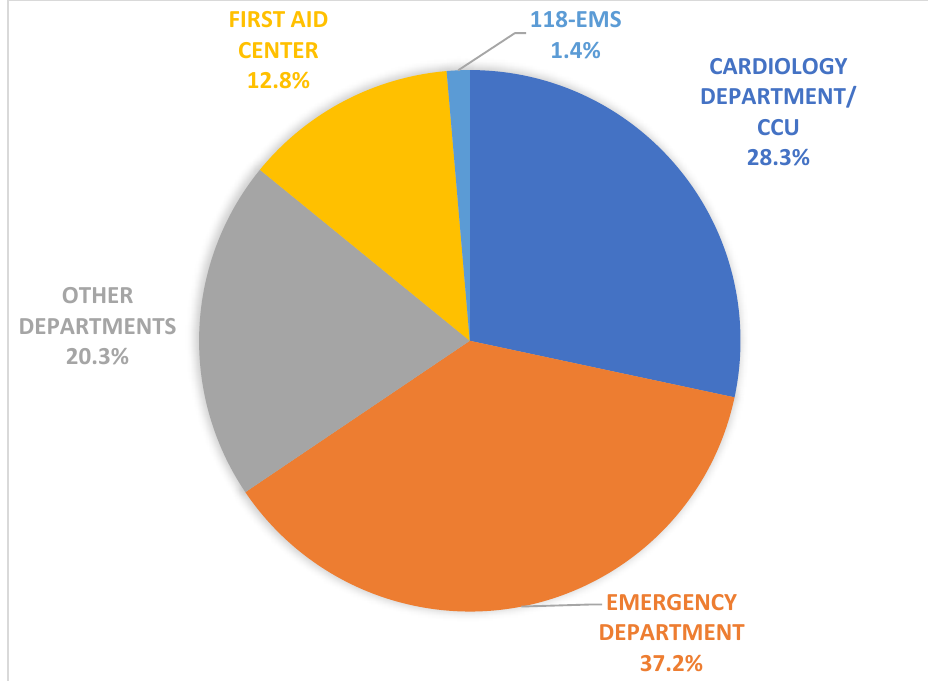
Figure 2. Distribution of ECGs according to department of origin.